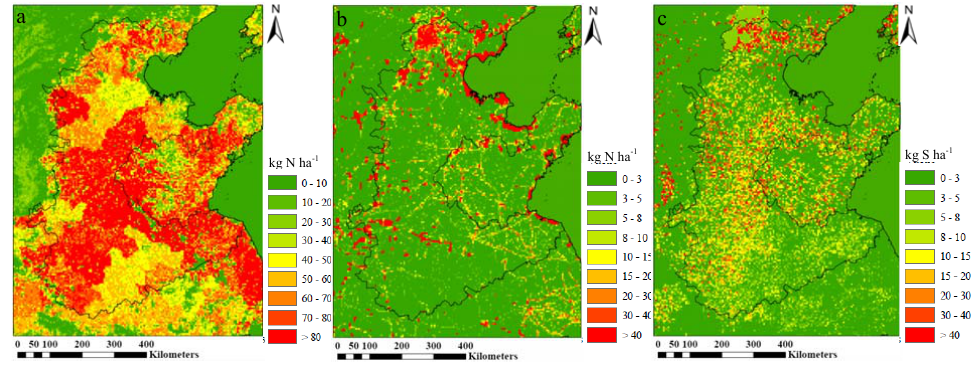
Figure 2. Emissions of NH 3 (a), NO y (b) and SO 2 (c) in the NCP in the year 2008. Fig. 2. Emissions of NH 3 (a) , NO y (b) and SO 2 (c) in the NCP in the year 2008.